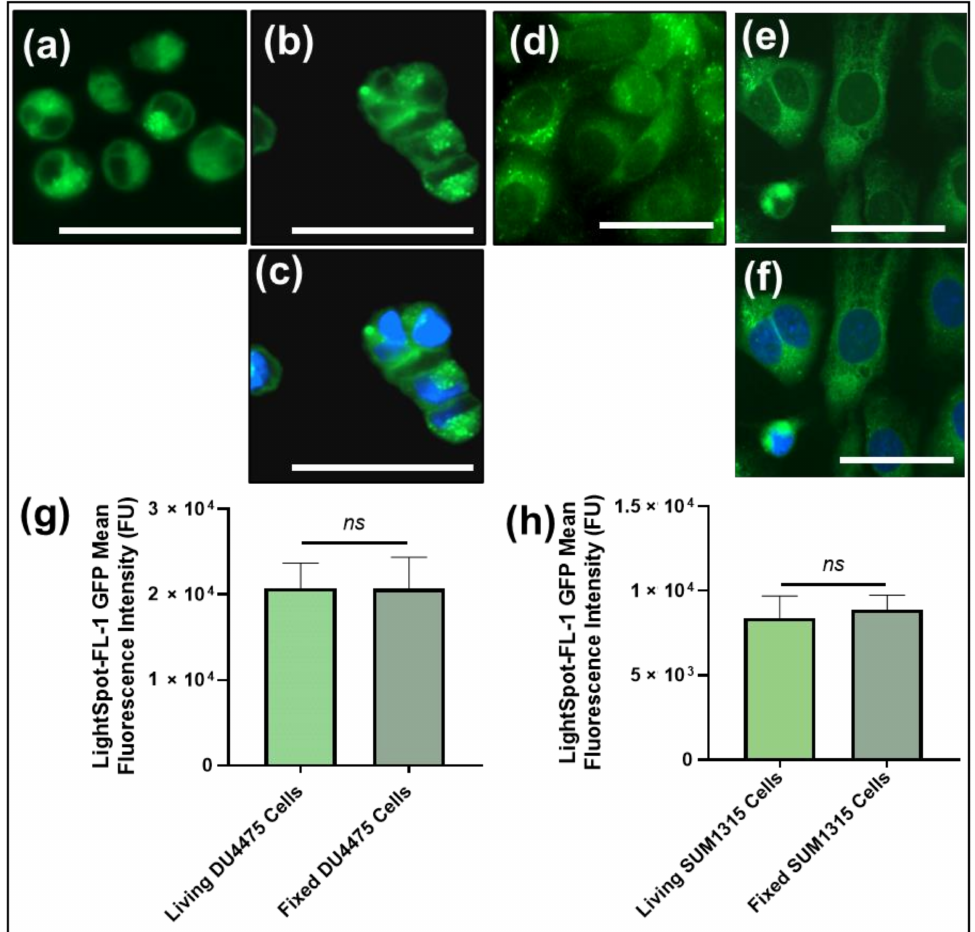
Figure 3. LightSpot ® -FL-1 staining comparison between living and fixed DU4475 and SUM1315 TNBC cell lines. Living ( a ) or fixed ( b ) DU4475 cells and living ( d ) or fixed ( e ) SUM1315 cells were stained with the LightSpot ® -FL-1 probe at 1 µ M (green signal). In parallel, a nuclear counterstaining was also carried out using Hoechst33258 for fixed DU4475 ( c ) and SUM1315 ( f ) cell conditions (merged pictures presenting LightSpot ® -FL-1 signal in green and nuclear staining in blue). All pictures were acquired with the Cytation™3 MV (BioTek ® , M = 4 X, scale bar = 50 µ m). For each experimental condition, LightSpot ® -FL-1 global cell fluorescent intensity was measured with Gen5 software (BioTek ® ) for DU4475 ( g ) and SUM1315 ( h ) cells. Significances between living and fixed conditions were indicated as ns (not significant; p >